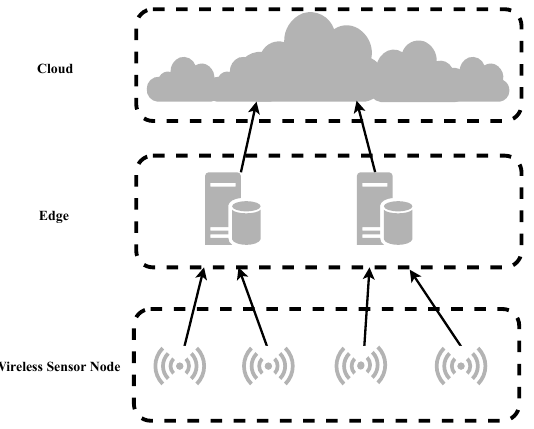
Figure 4. Edge computing architecture